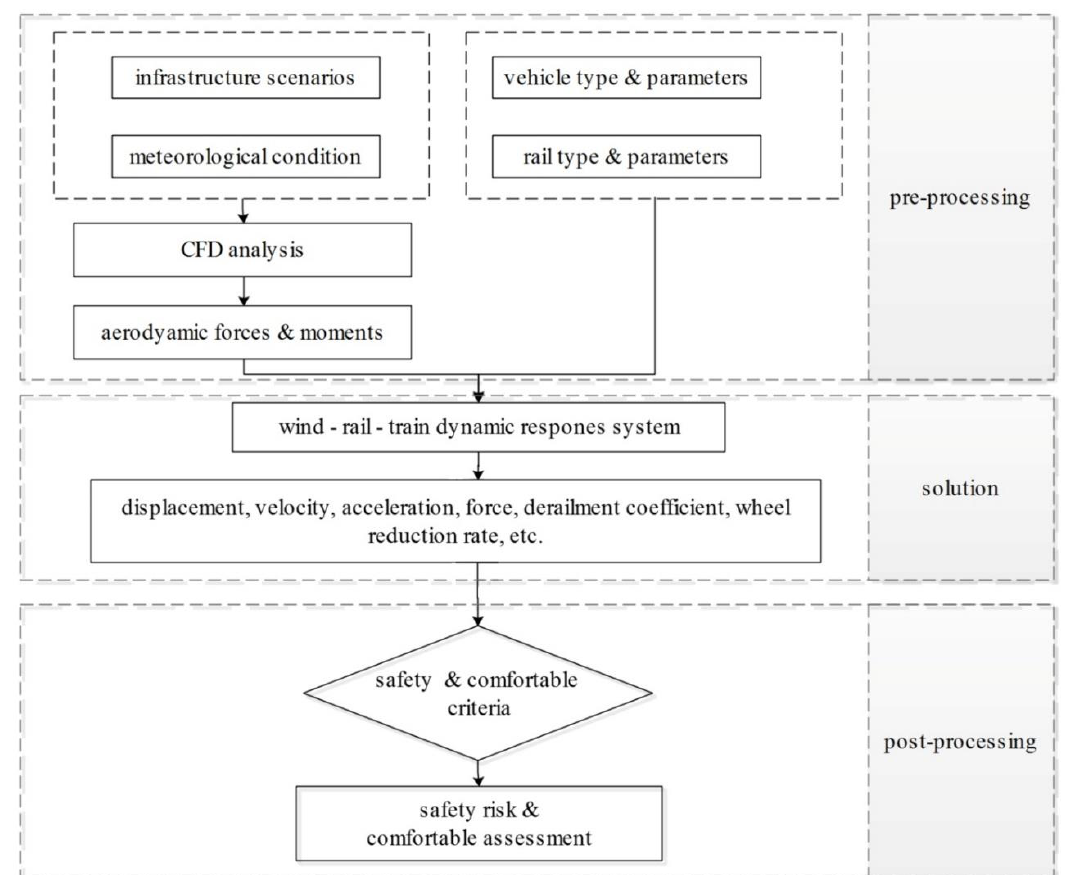
Figure 8. Outline of the wind–train–rail structure (WTRSDYNA) coupling solution.